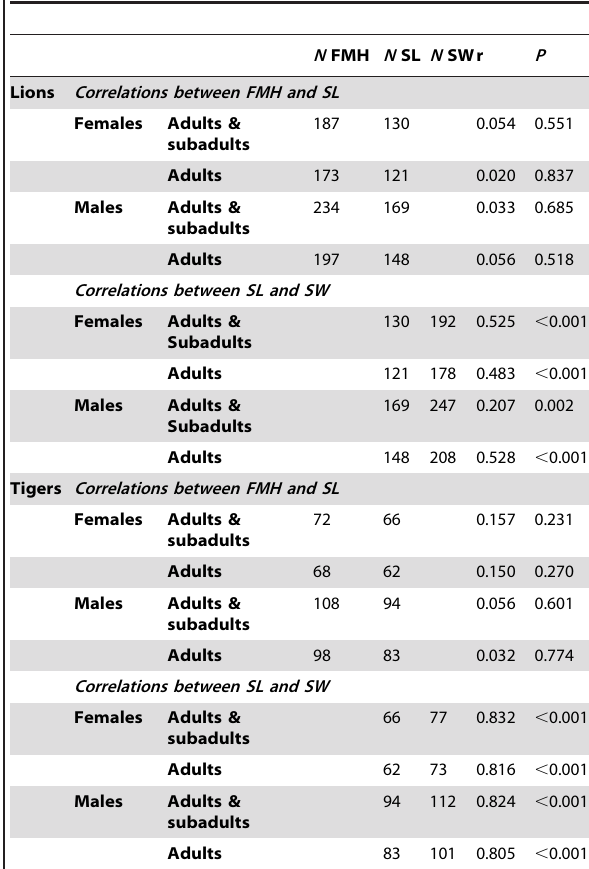
Table 2. Pearson Correlations between FMH and SL and between SL and SW in lions and